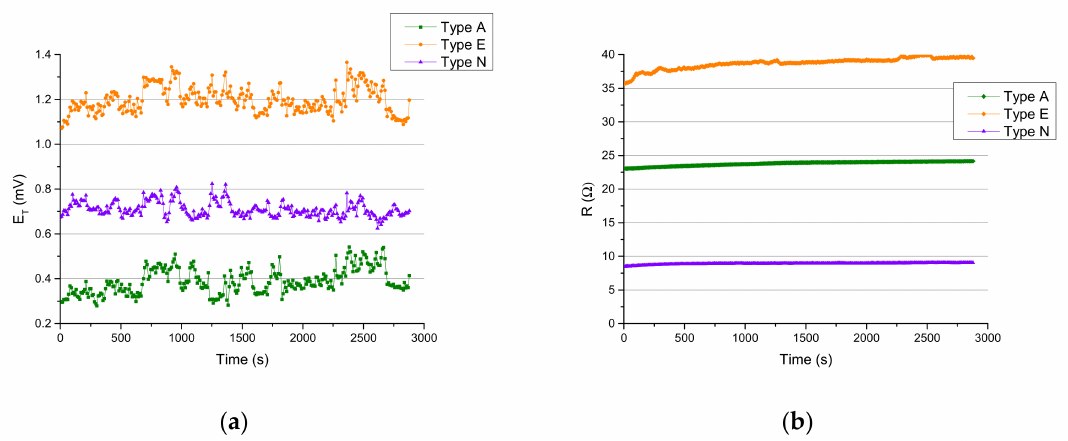
Figure 16. Sensors A, E and N characteristics during warming up the heater: ( a ) output voltage responses vs. time; ( b ) internal resistance vs.